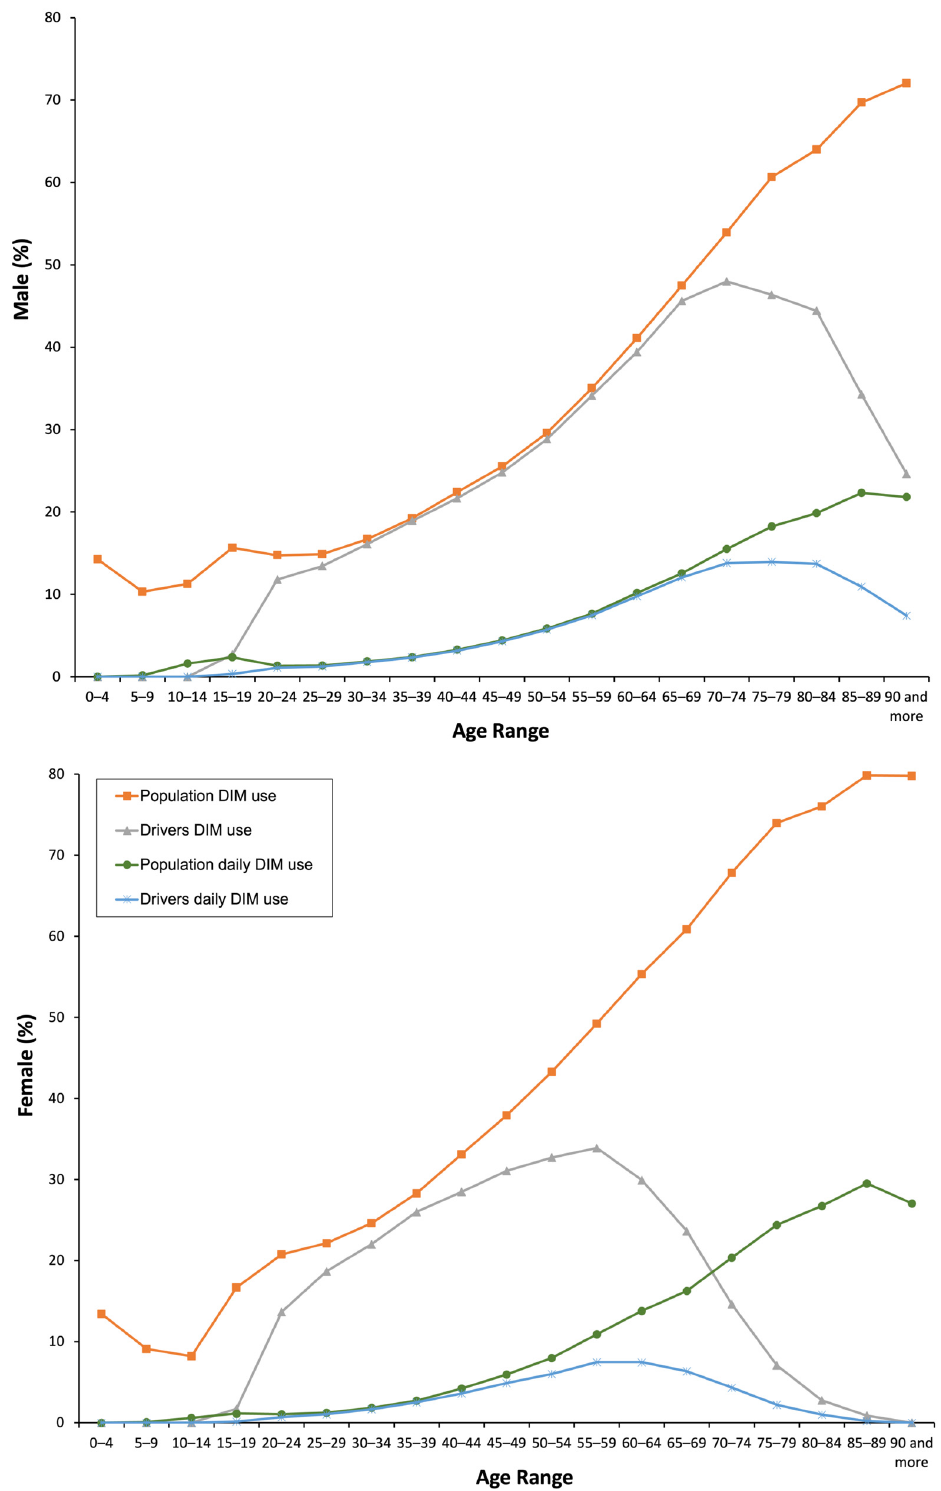
Figure 1. Frequency of the use of DIMs by the general population and the driver population.